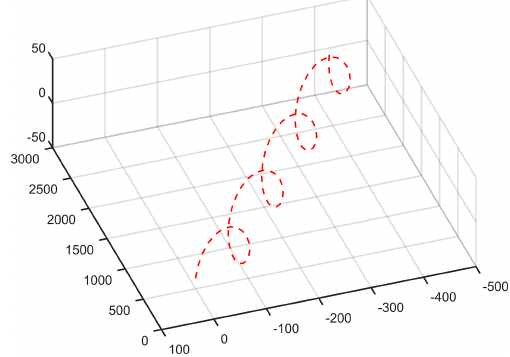
Figure 7. Trajectory diagram of the spiral blade.